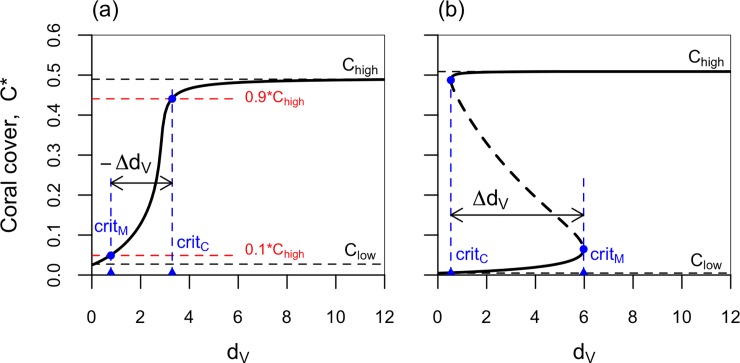
Bifurcation diagrams illustrating model output metrics.In (a), ΔdV
<0 and there is only a single coral steady state for each value of dV. In (b) ΔdV >0 and alternative stable states exist for the values of dV between critC and critM, and an unstable equilibrium (dashed black line) exists between the two stable equilibria.